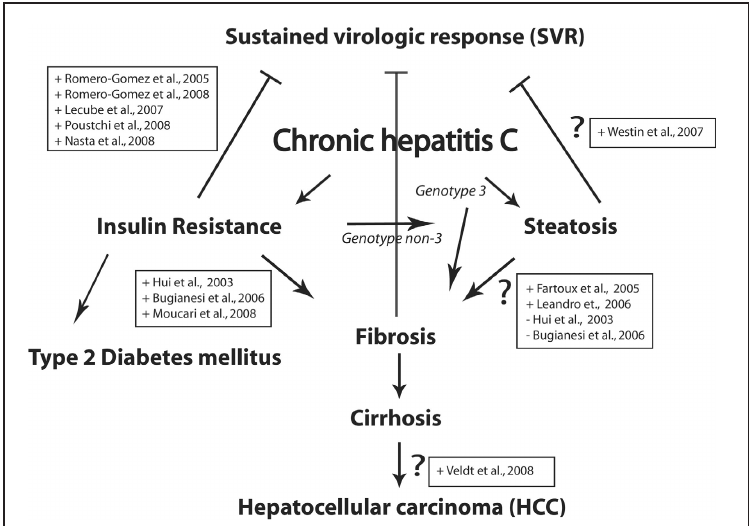
Consequences of insulin resistance in chronic hepatitis C. Insulin resistance in chronic hepatitis C is a risk factor for fibrosis progression and impairs antiviral treatment re- sponse. Steatosis in genotype 3 infection is probably independent of insulin resistance and may not influence fibrosis progression or response to therapy. ( → , positive asso- ciation, , negative association/